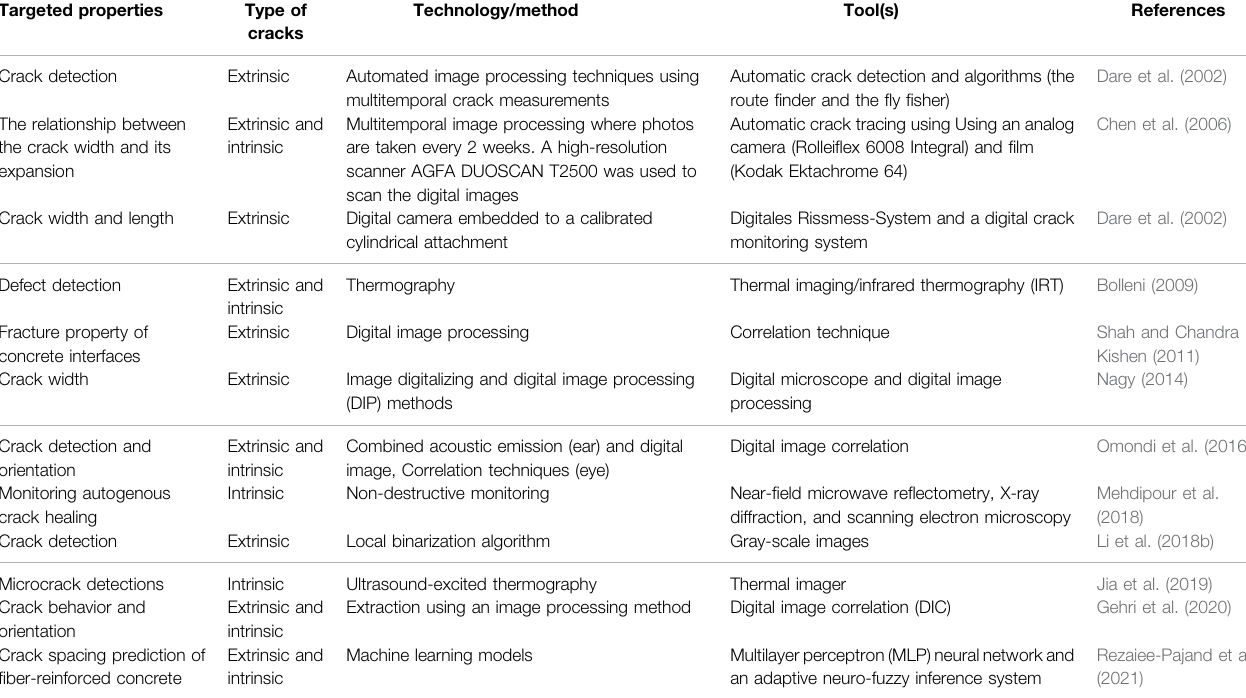
TABLE 7 | Concrete crack monitoring using digital